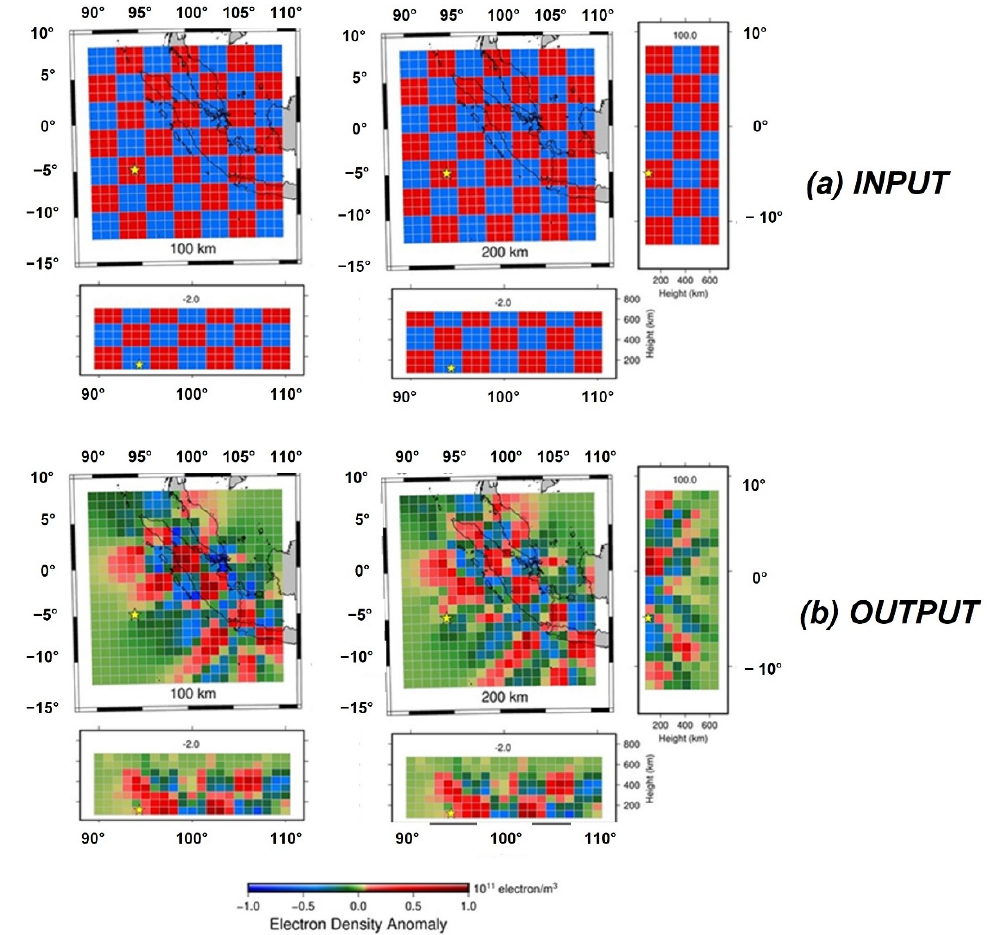
Figure 2. Resolution test with the classic checkerboard pattern. ( a ) Assumed electron density as the input and ( b ) output of 3D tomography are given in map view and north–south, east–west profile.